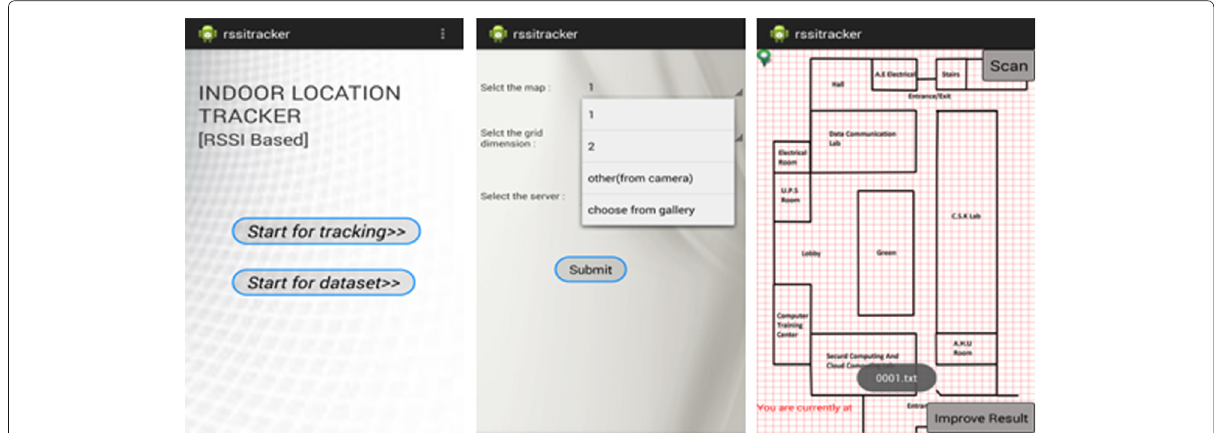
Fig. 2 Mobile user interface of the